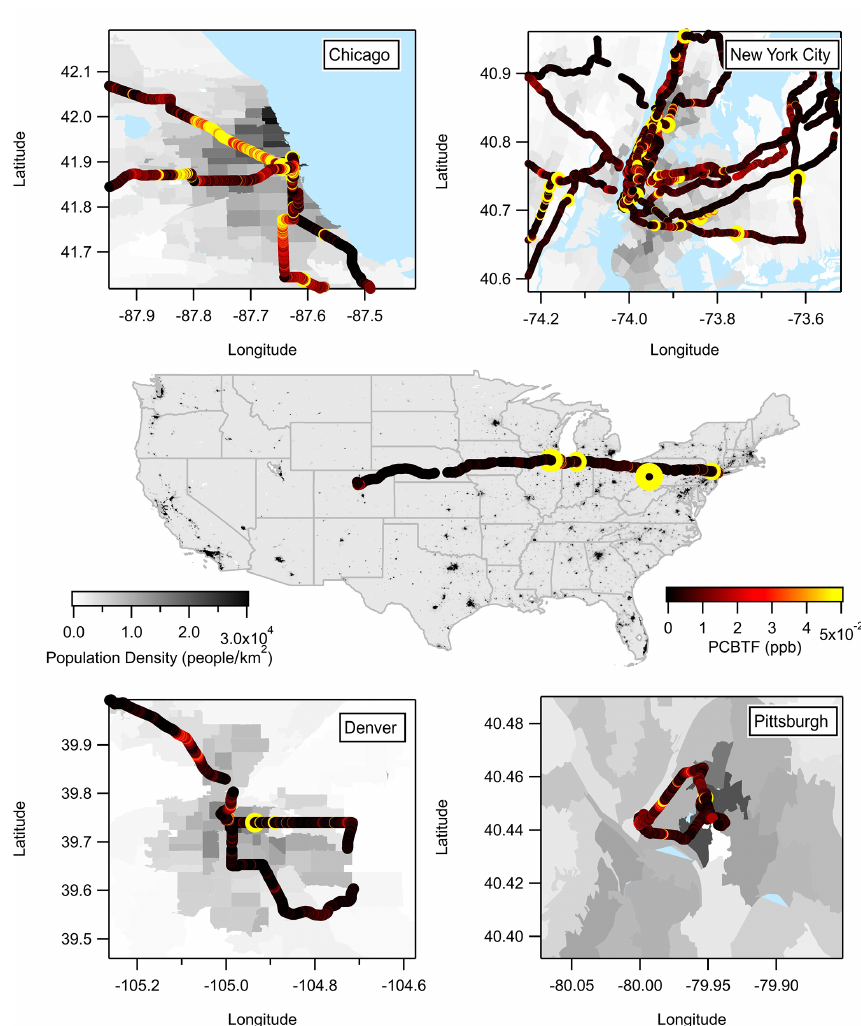
Figure 2. Summary of the PCBTF measurements from Chicago, New York City, Denver, Pittsburgh, and the transition drives between the